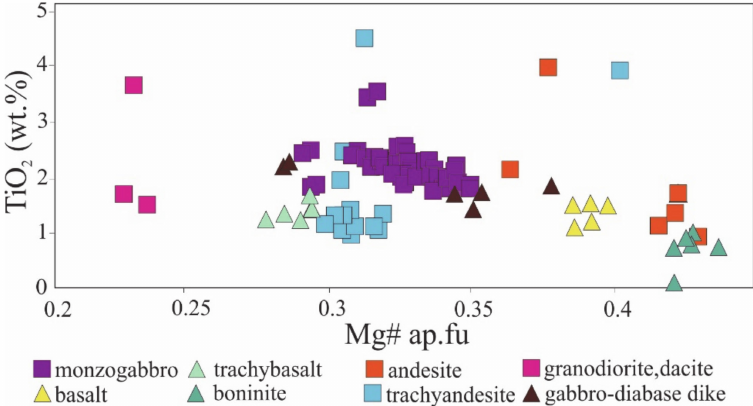
Figure 10. Ratio of Mg# vs. TiO 2 wt.% in the biotites of di ff erent lithologies. The squares indicate the primary biotites and the triangles indicate secondary